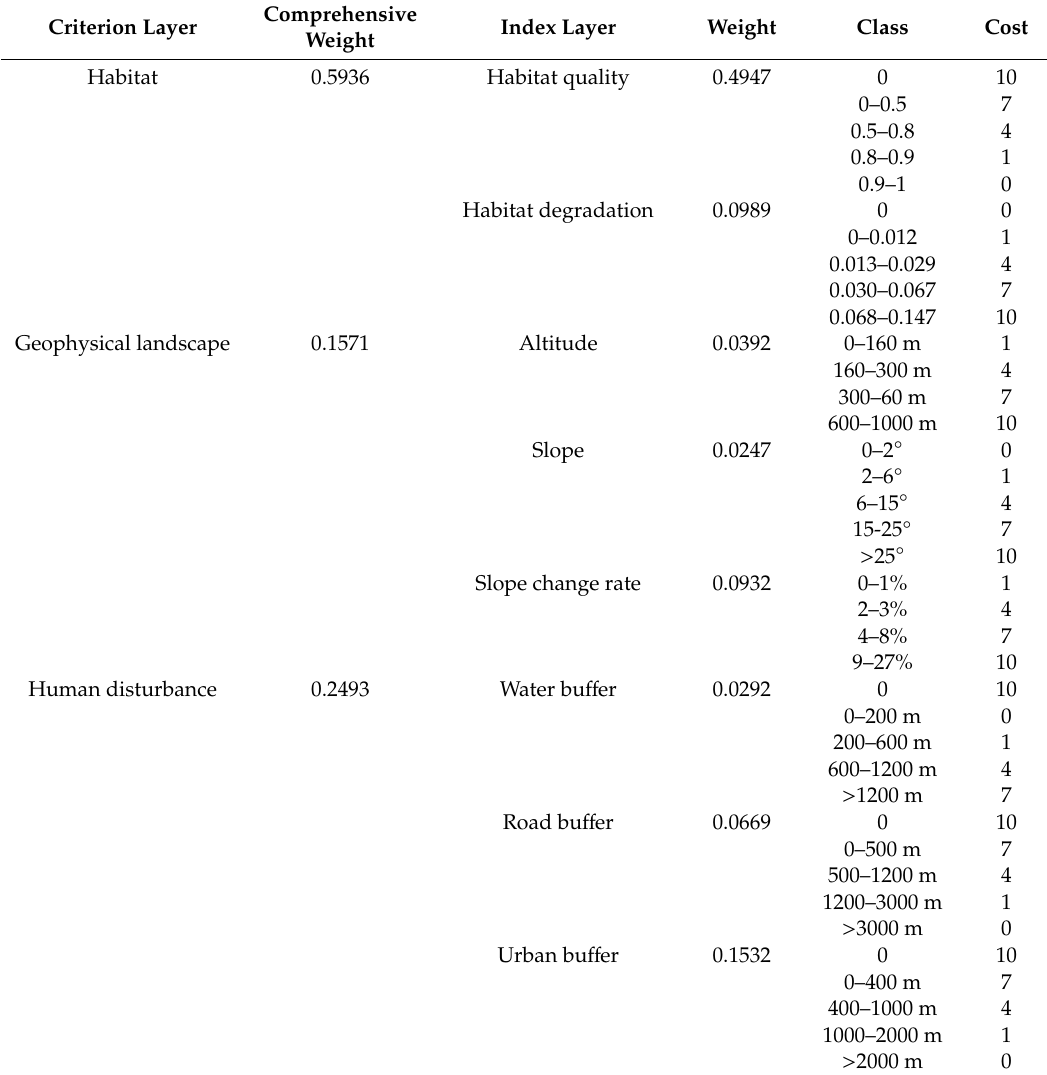
Table 3. Evaluation indicators for bird cost